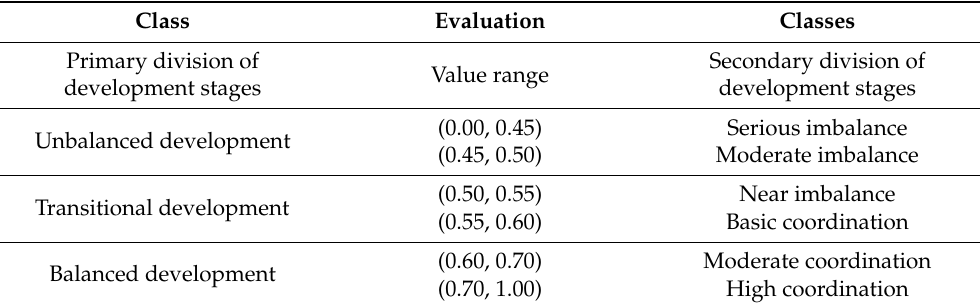
Table 3. Classification of the coupling coordination degree between RLUT and FS.